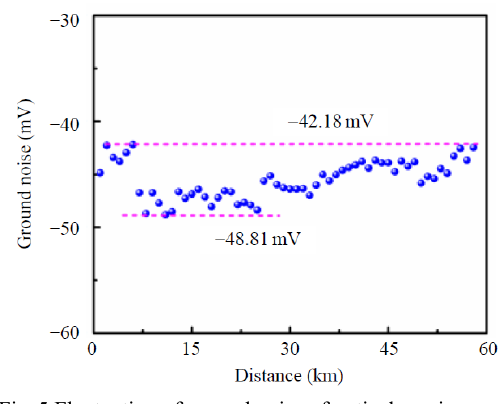
Fig. 5 Fluctuation of ground noise of optical receiver.